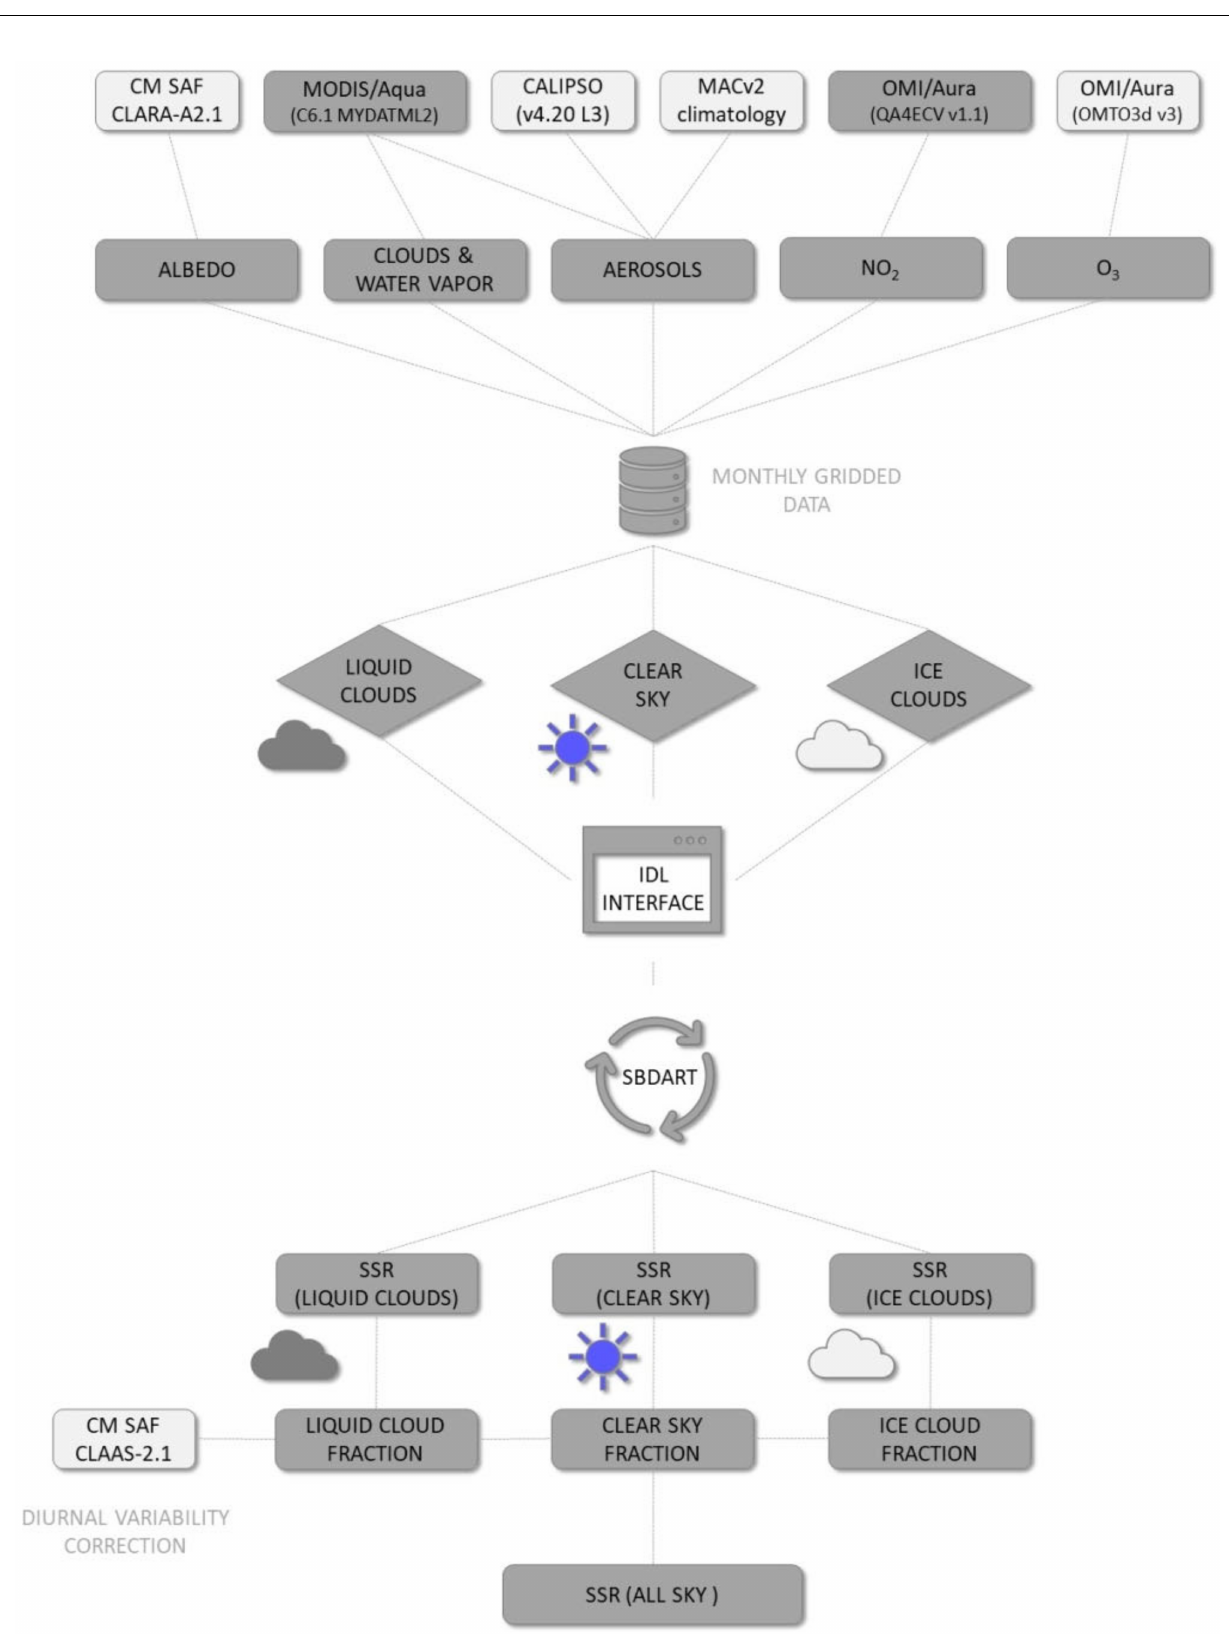
Figure 1. Flowchart with the datasets, the methodology and the radiative transfer system used in this work. Dark grey is used for the core and light grey for the ancillary